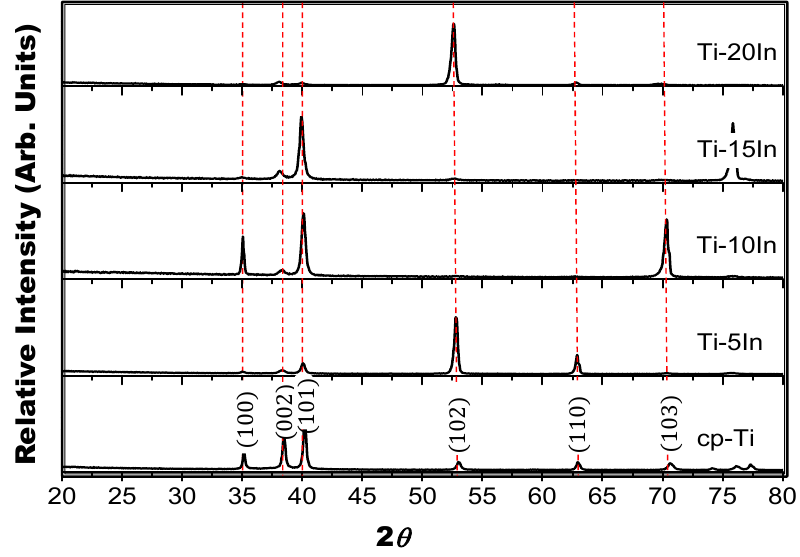
Figure 2. X-ray diffraction (XRD) patterns of commercially pure Ti (cp-Ti) and the series of binary Ti- x In alloys. The vertical dotted line in the figure is a guide to the eye, and it connects the peak positions of the α -Ti